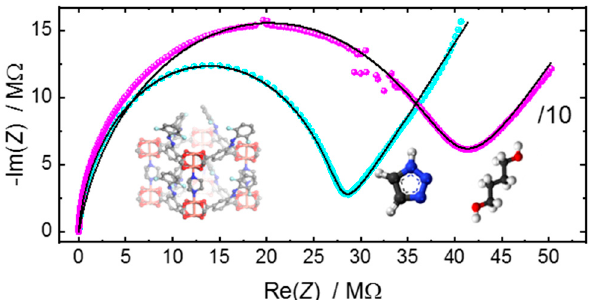
Figure 4. Nyquist plots of the proton-conduction of triazole (cyan) and butanediol (magenta) in a pillared-layered SURMOF on an IDE-substrate. The SURMOF structure and the molecules are sketched in the insets. The impedance values for butanediol are divided by 10, to allow the presen- tation in the same plot. The black lines are the fits with the ( R-CPE dl ) ‖ CPE geo . The frequency range is 0.5 Hz to 5 MHz. The SURMOF sample was 150 nm thick, deposited on a substrate with IDEs of 10 µm gap distance, with a total gap length of 2 cm. The frequency range is 0.5 Hz to 5 MHz. The data were previously published in [26] with copyright permission from 2018 WILEY-VCH Verlag GmbH & Co. KGaA.